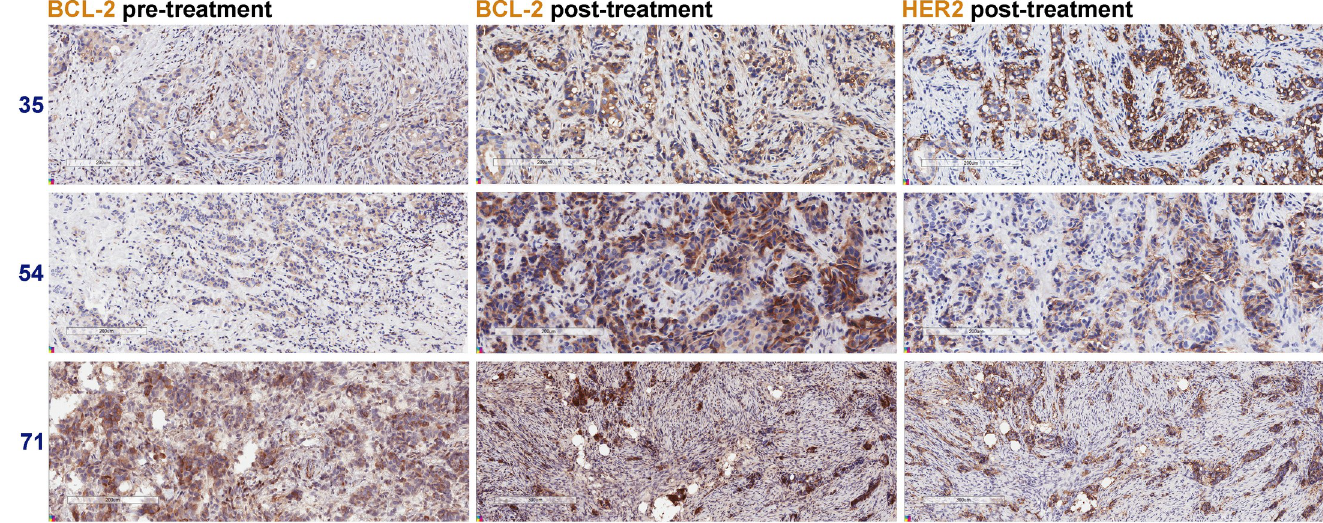
Fig 5. Lapatinib-induced BCL-2 upregulation post-treatment. Comparison of BCL-2 levels pre- and post-treatment for cases #35, #54 and #71. HER2 serial section IHC identified the tumor cells post-lapatinib. Scale bars, 200–300 μ m.